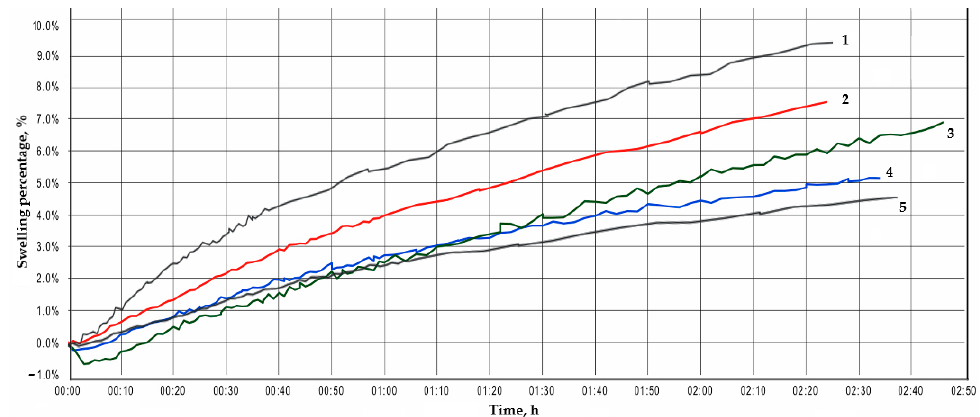
Figure 5. Swelling curves of clay samples in the investigated solutions. 1—“VPRG”; 2—“ РНР A 12”; 3—“ РНР A 15”; 4—“ РНР A 20”; 5—“ РНР A 27”.